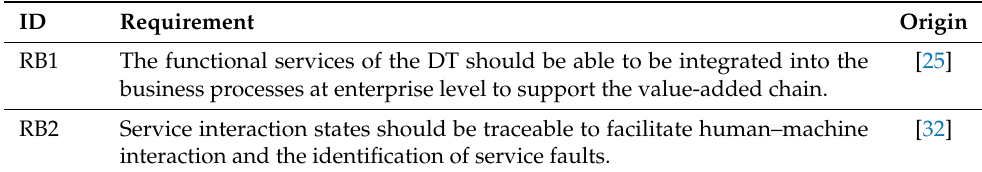
Table 4. functional requirements for the Business Layer.